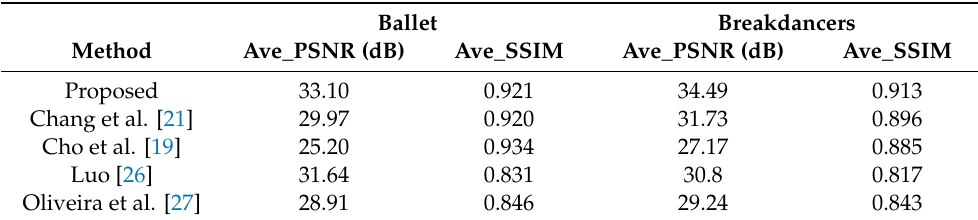
Table 3. Comparative